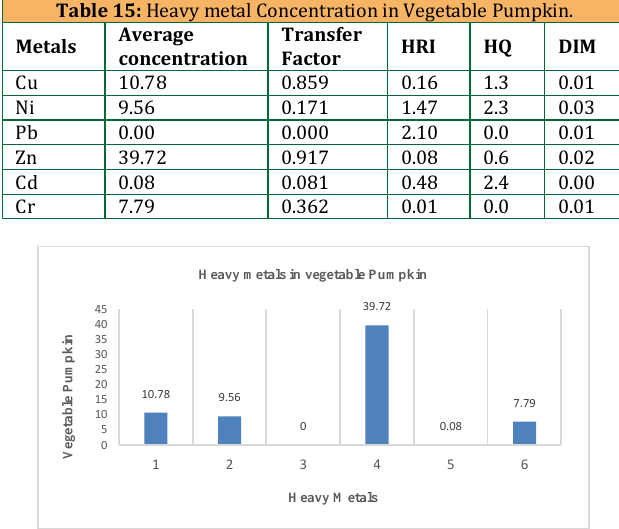
Figure 12: Average Concentration in vegetable Pumpkin